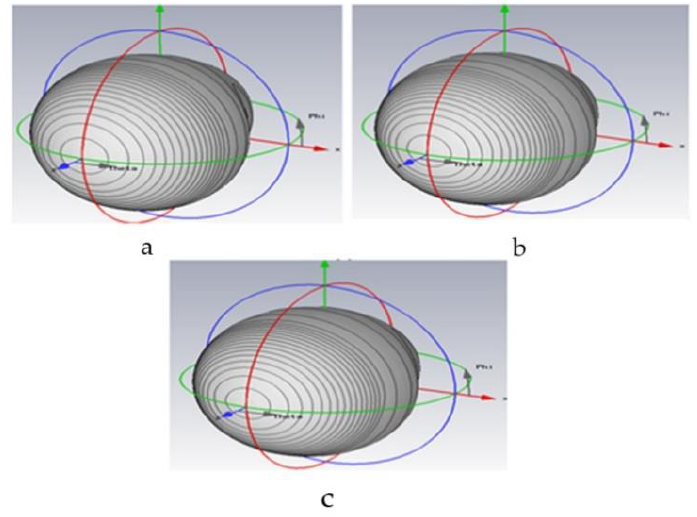
Table 3. Antennas performance.